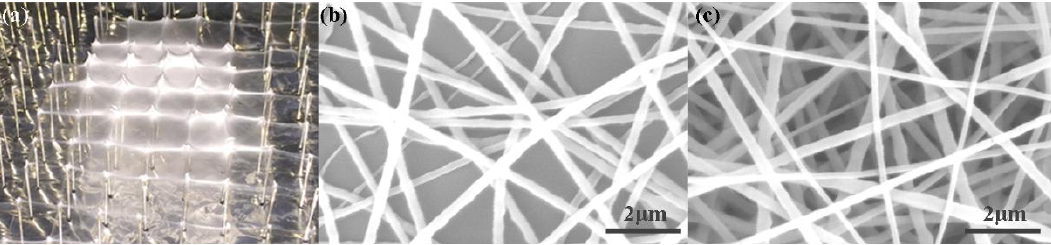
Figure 5. 3D nanofibrous structure printed on multiprobe arrays. ( a ) Photograph of 3D nanofibrous structure; ( b ) SEM image of nanofibers deposited among the probes; ( c ) SEM image of nanofibers deposited on the tip of probes. The probe height, probe interval, applied voltage, and flow rate were 20 mm, 10 mm, 25 kV, and 300 μL/ h, respectively.